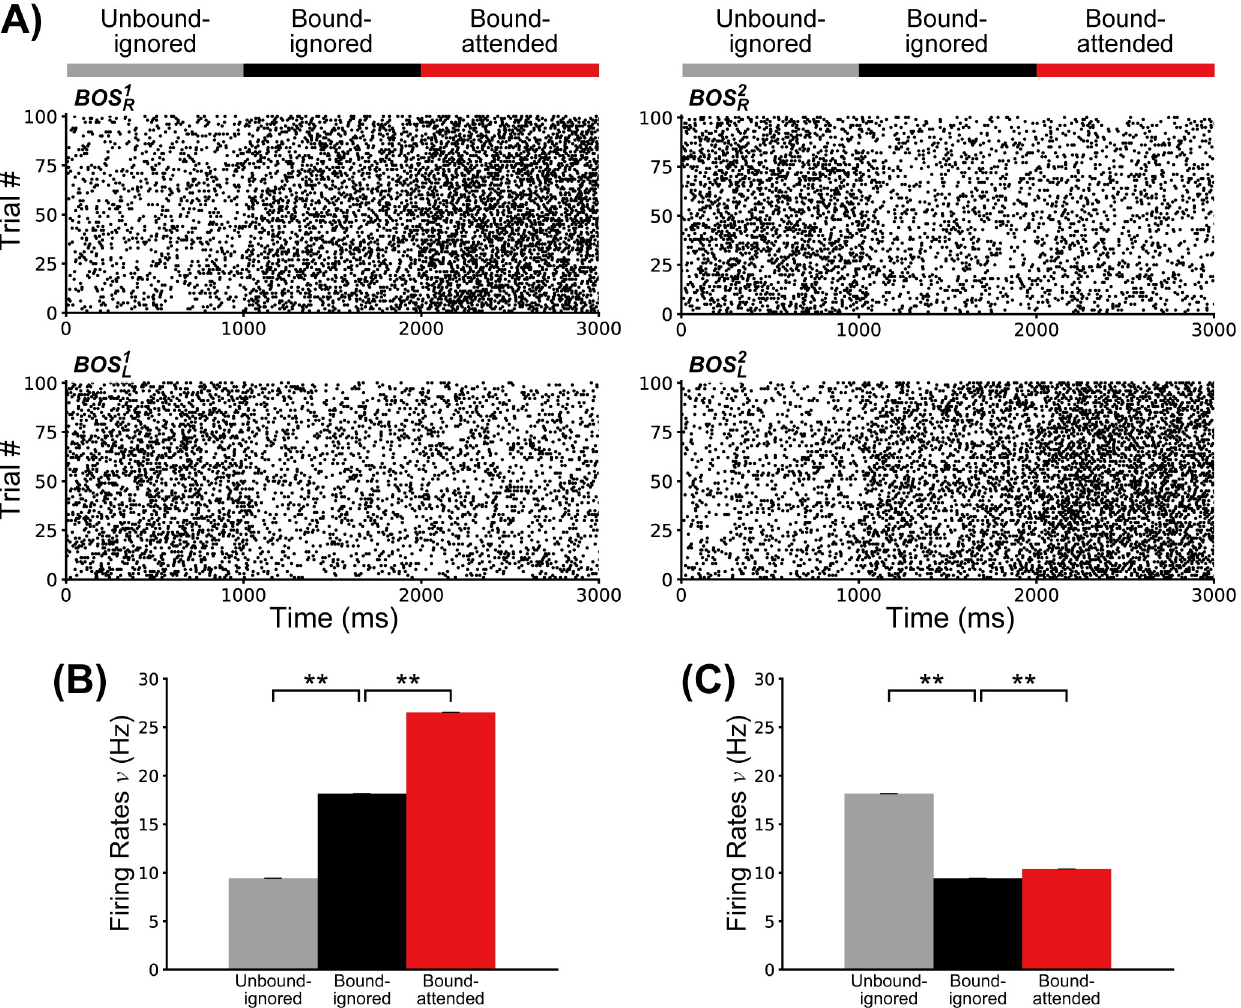
Fig 3. Responses of BOS neurons. A: Raster plots showing 100 spike trains of BOS model neurons. For these plots, G-cells were activated for representing the Unbound-ignored condition between 0 and 1000 ms, the Bound-ignored condition for 1000 and 2000 ms, and the Bound-attended condition for 2000 and 3000 ms. Feedback from G-cells modulates the firing rates of BOS neurons. Identities of BOS neurons are shown next to each plot. B: Firing rates of preferred neurons ( BOS 1 and BOS 2 ). C: Firing rates of non-preferred neurons ( BOS 1 and BOS 2 ). The gray, black, and red bars represent the Unbound-ignored, Bound- R L L R ignored, and Bound-attended conditions, respectively, during trials that mimic the experimental settings of the Martin and von der Heydt study (ref. [39], their Fig 4B). These firing rates were obtained from 10 sets of 100 simulated trials, each of a length of 200 biological seconds. Error bars indicate standard deviations (SDs), which were very small in these simulations. Confidence intervals of preferred neurons were 9.42 ± 0.01 ( SD = 0.02), 18.15 ± 0.01 ( SD = 0.02), and 26.54 ± 0.01 ( SD = 0.02) Hz for the Unbound-ignored, Bound-ignored, and Bound-attended conditions, respectively. Confidence intervals of non- preferred neurons were 18.15 ± 0.01 ( SD = 0.02), 9.41 ± 0.01 ( SD = 0.01), and 10.38 ± 0.01 ( SD = 0.01) Hz for the Unbound-ignored, Bound-ignored, and Bound-attended conditions, respectively. Asterisks indicate significant differences between conditions ( �� p < 0.01 by